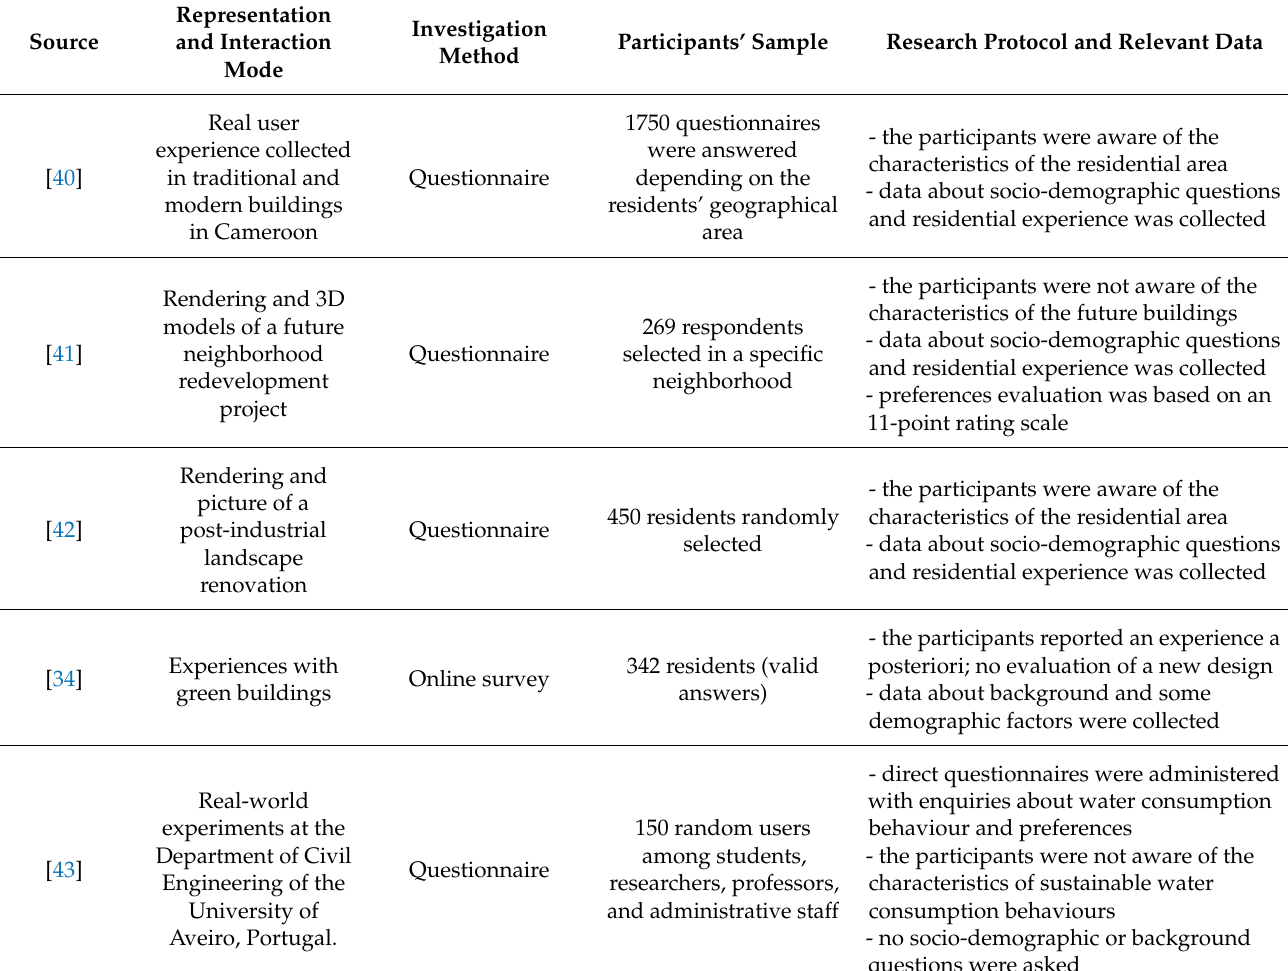
Table 1. Summary of extant literature contributions dealing with the evaluation of sustainable designs within buildings and the built